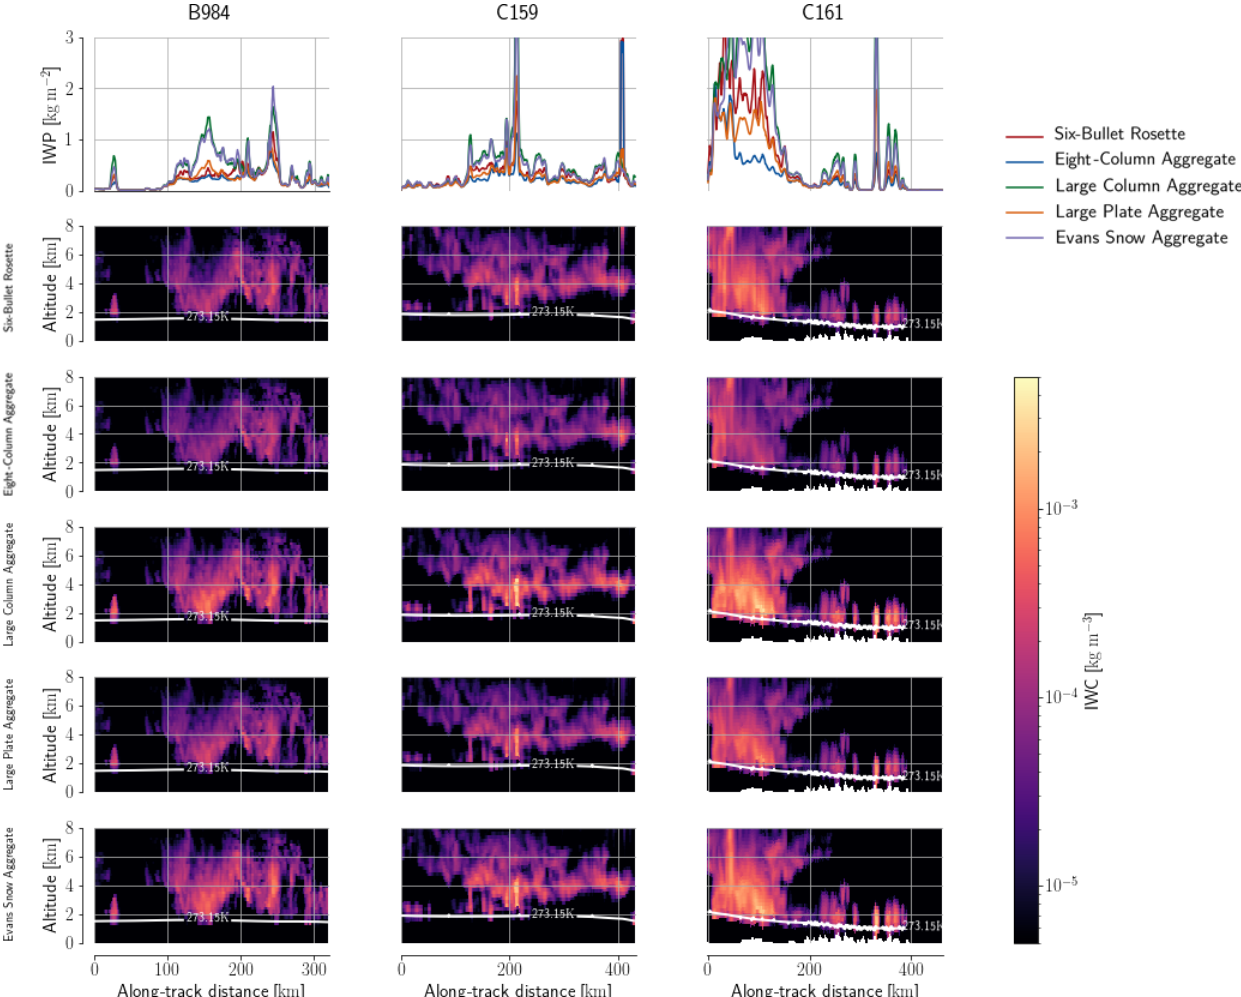
Figure 12. Retrieved IWP and IWC content for all flights and different ice particle shapes assumed in the retrieval. The white line displays the ERA5 freezing level from Hersbach et al.